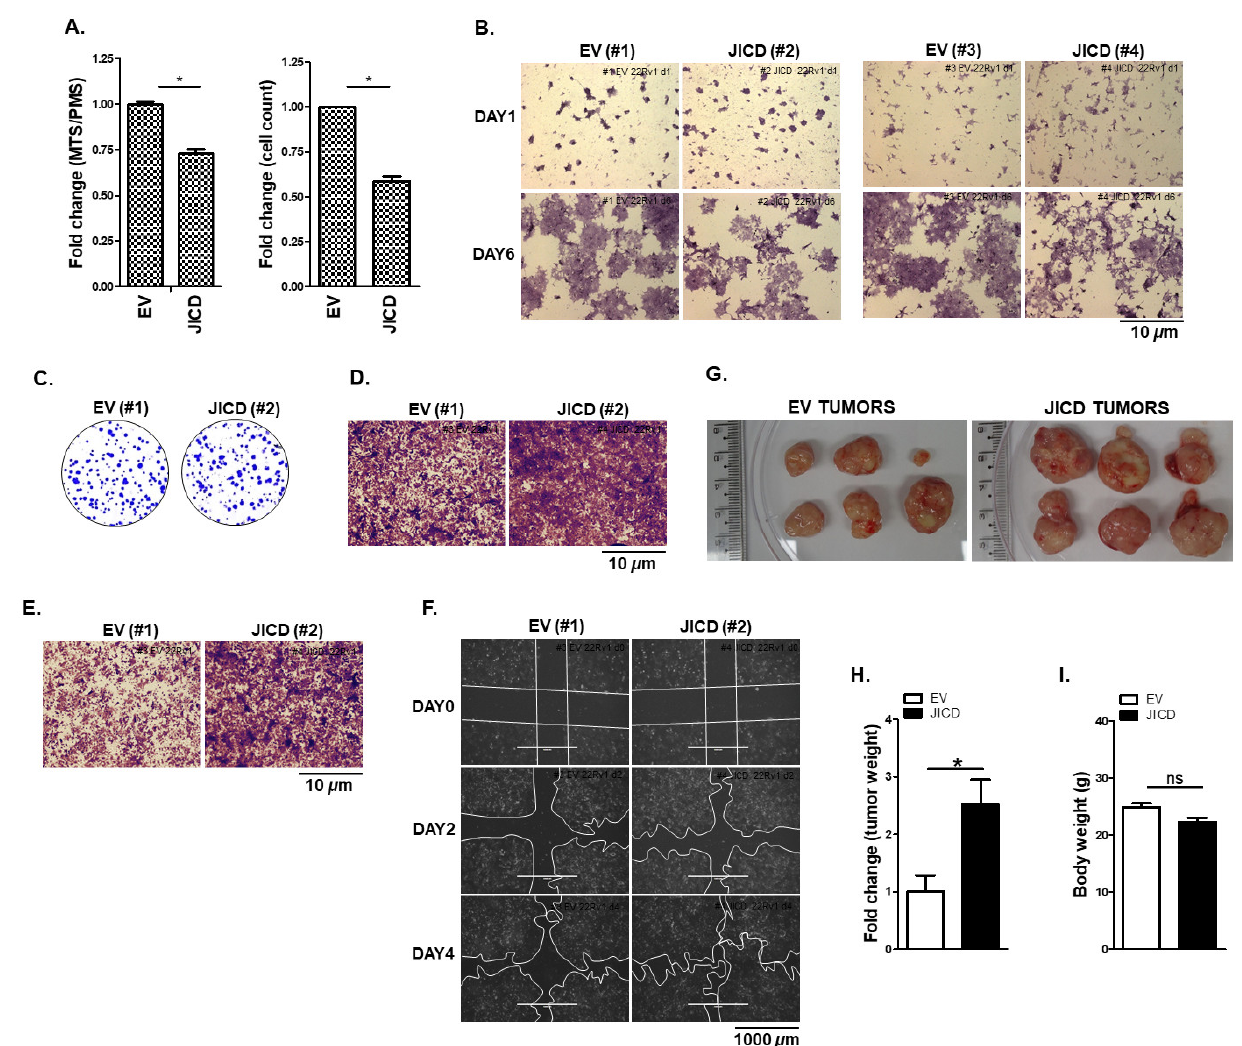
Figure 5. JICD overexpression increases prostate cancer cell mobility and in vivo tumorigenesis. ( A , B ) Stable JICD overexpression reduces the proliferation and viability of CWR22Rv1 cells. Stable EV (#1) or JICD (#2) CWR22Rv1 subline cells were maintained for 3 days and then subjected to MTS/PMS assays ( A , left ) or cell counting assay ( A , right ). Stable EV (#1 and #3) or JICD (#2 and #4) subline cells were maintained for 1 and 6 days, stained with crystal violet, and imaged via ZEISS microscopy at 20× magnification (scale bar 10 μ m) ( B ). Data are shown as mean ± SEM. *, p < 0.01; two-tailed t -test. ( C ) Colony size increases in stable JICD-overexpressing CWR22Rv1 subline cells compared with that in the control without significant difference in the total number of colonies be- tween them. Stable EV (#1) or JICD (#2) subline cells were maintained for 2 weeks and then pro- cessed for 0.5% crystal violet staining. Colonies were imaged with a normal camera. ( D – F ) JICD increases the mobility of prostate cancer cells. Invasion assays of stable EV (#1) or JICD (#2) CWR22Rv1 subline cells ( D ). Cell invasion was allowed to occur for 48 h, stained with crystal violet, and imaged via ZEISS microscopy at 10× magnification (Scale bar = 10 μ m). Boyden Chamber mi- gration assay of stable EV– or JICD–overexpressing CWR22Rv1 cells ( E ). Cells were allowed to mi- grate for 24 h, stained with crystal violet, and imaged with ZEISS microscopy at 10× magnification (Scale bar = 10 μ m). Scratch wound-closure assay of stable EV (#1) or JICD (#2) CWR22Rv1 subline cells ( F ). Scratch wounds were generated (day 0, D0), and wound distances were monitored for 2 (D2) and 4 (D4) days; they were then imaged using EVOS ®® FL Cell Imaging System at 4× magnifi- cation (Scale bar = 1000 µm). Boundary lines were simply drawn using the shape tool from Power- Point. ( G – I ) JICD overexpression promotes CWR22Rv1 xenograft tumor growth in vivo. Stable JICD–overexpressing (JICD; #2) or control (EV; #1) CWR22Rv1 subline cells were implanted into the shoulders of 4–week–old male NOD.CB17–PrkdcSCID/J mice, and tumors were allowed to grow for 7 weeks. Representative tumors ( G ) dissected from mice after 7 weeks. Tumor weight ( H ) and body weight ( I ) measured after 7 weeks. Data are shown as mean ± SEM, two independent biological in vivo experiments ( n = 6 mice per each group). *, p < 0.01; ns, not significant; two–tailed t –test.